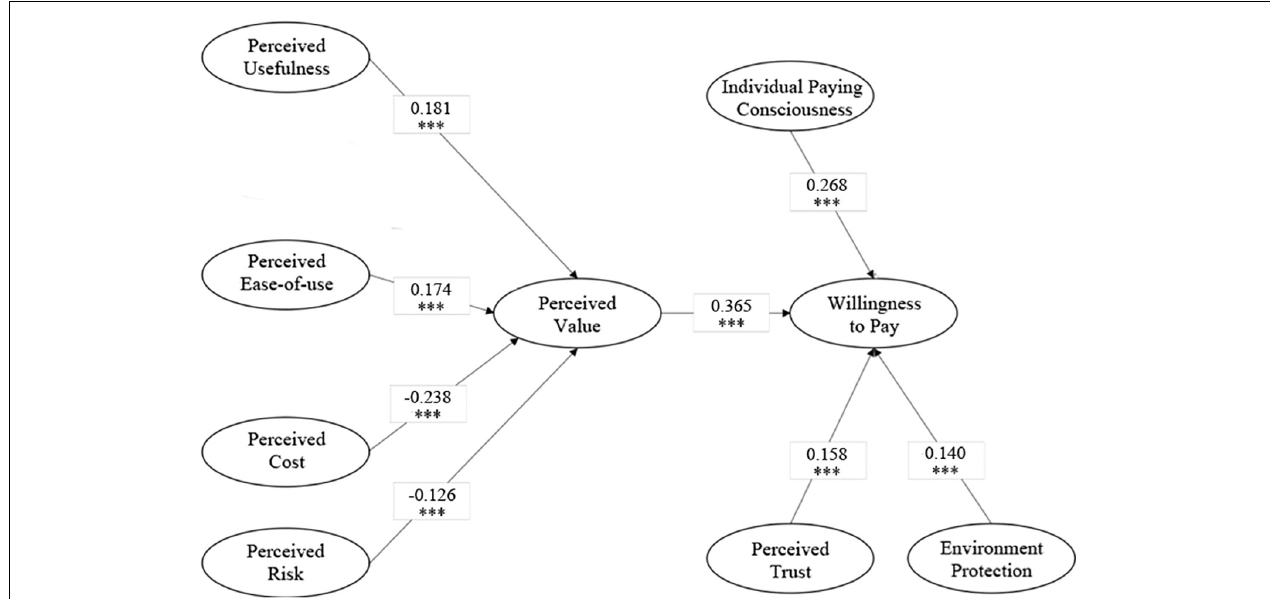
FIGURE 5 | Influence path of modified structure equation model. ∗∗∗ suggests the significance at the level of